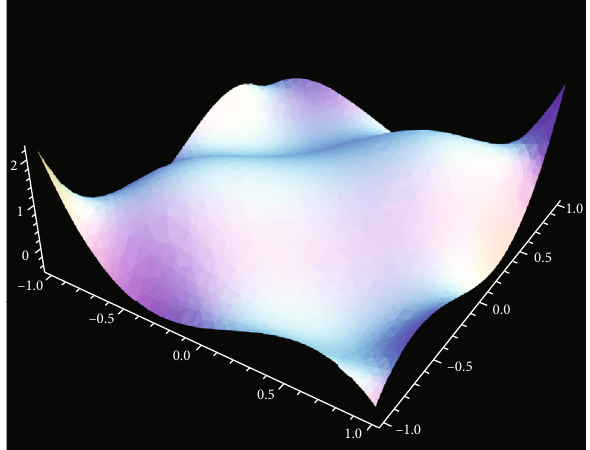
y Þ with n = 3, α = β = − 0 : 5 . x ð